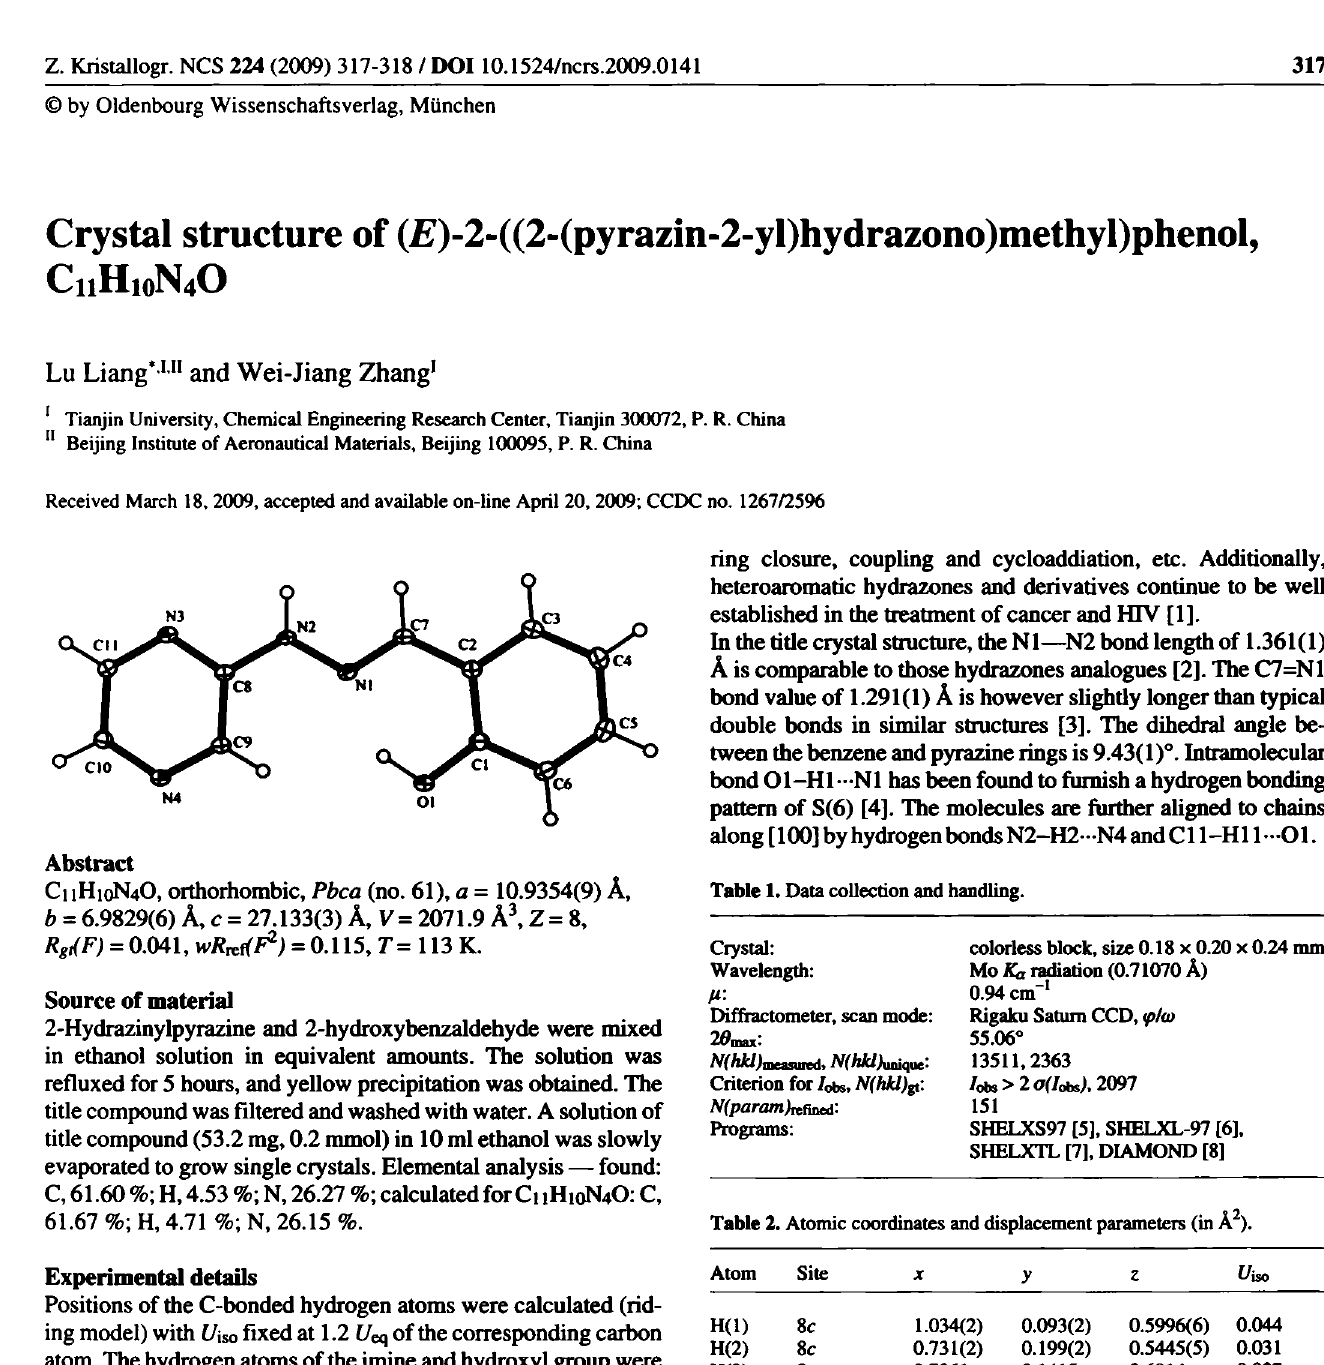
Table 3. Atomic coordinates and displacement parameters (in À 2